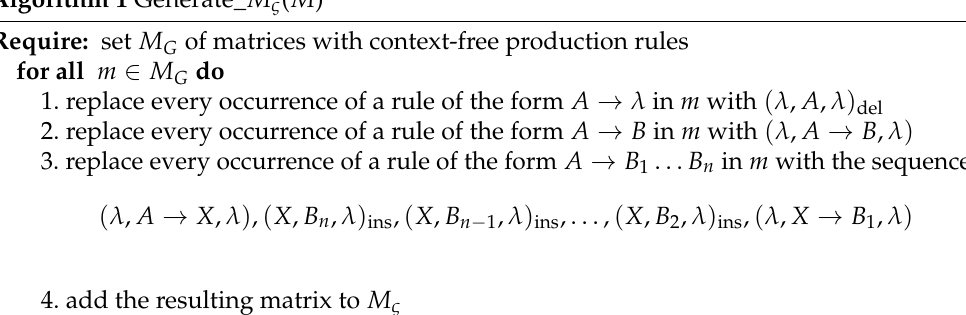
Figure 2. The tree group corresponding to a sentential form w = XY .